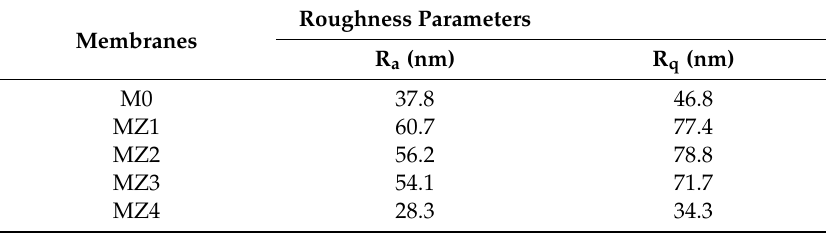
Figure 8. Atomic force microscopy (AFM) micrographs of the prepared membranes showing surface morphology variation with varying zwitterion content. Table 3. Surface roughness parameters for the prepared